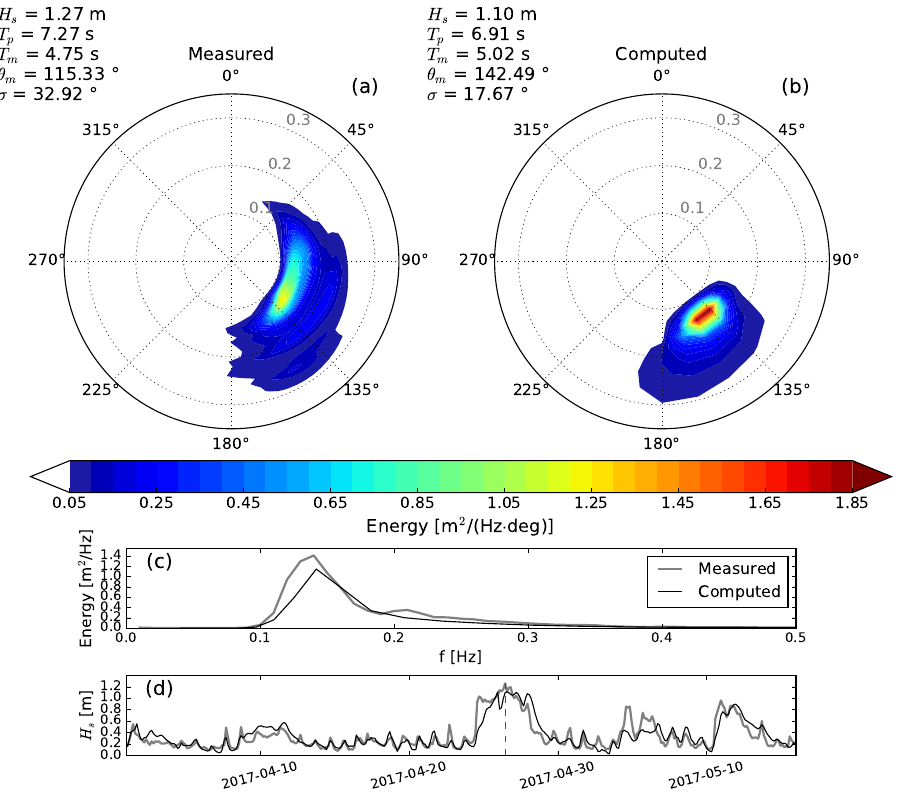
Figure 10. Measured ( a ) and predicted ( b ) two-dimensional wave spectra at the time instant of the measured maximum H s . One-dimensional frequency spectra are plotted in panel ( c ). Panel ( d ) displays the time series of H s . The time instant of the measured maximum H s is highlighted by a dashed red line in panel ( d